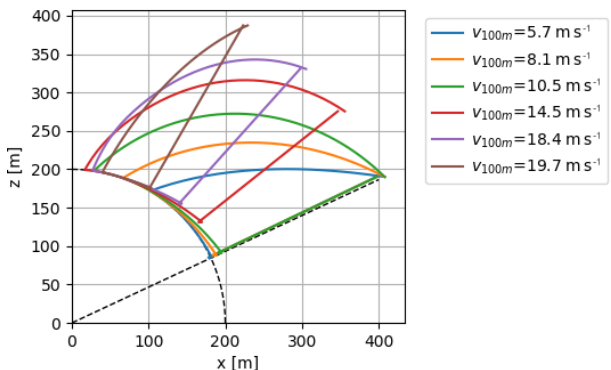
Figure 19. The optimal idealised cycle trajectories for six wind pro- files with the same cluster-mean wind profile shape, i.e. that of clus- ter MMC-1 but with different scaling. The wind speeds for which the trajectories are depicted highlight changes in the operational ap- proach. The angle of inclination of the straight dotted line is the minimum elevation angle. The radius of the dotted quarter circle shows the fixed minimum tether